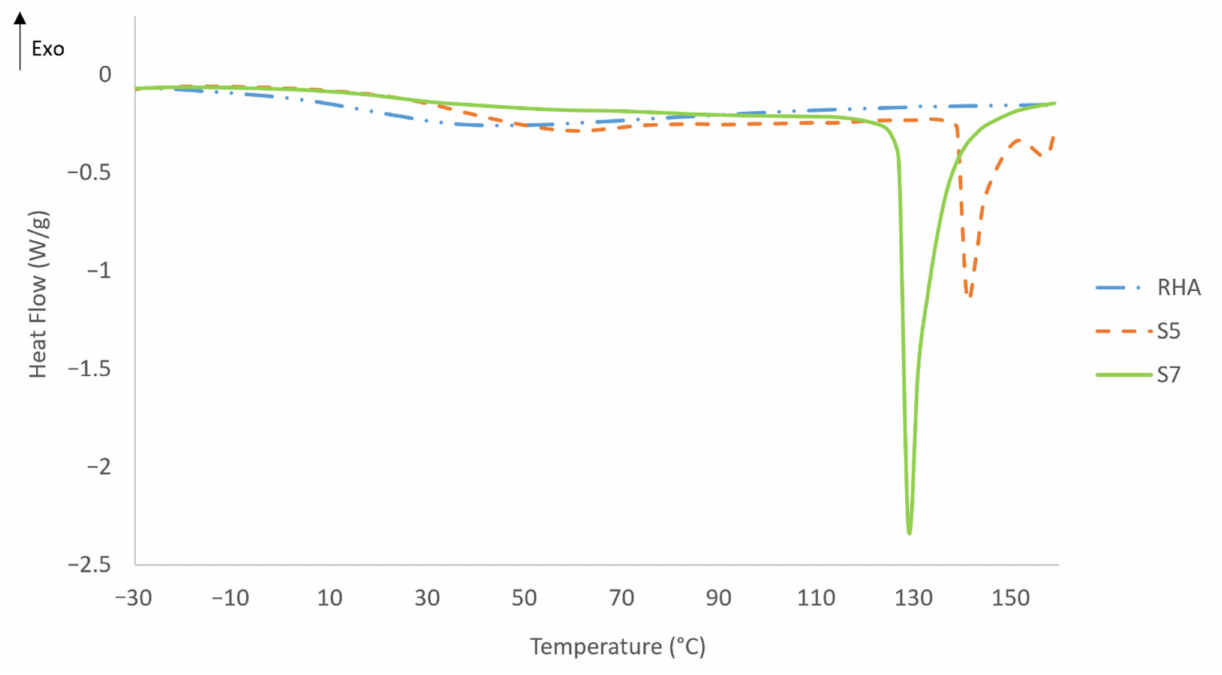
Figure 21. DSC result of RHA, sample S7 and sample S5 in fire-retardant